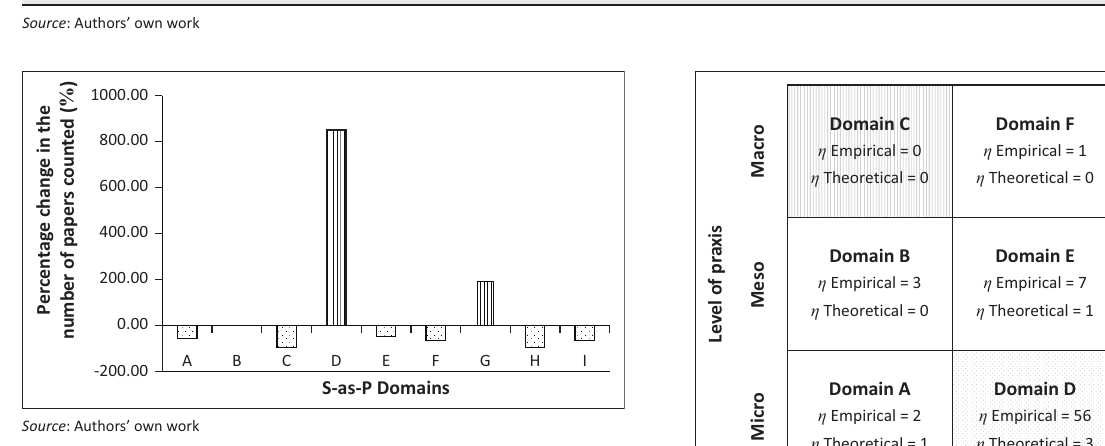
FIGURE 3: The percentage change in the number of papers counted in the strategy–as–practice) research domains between 2009 and 2015.